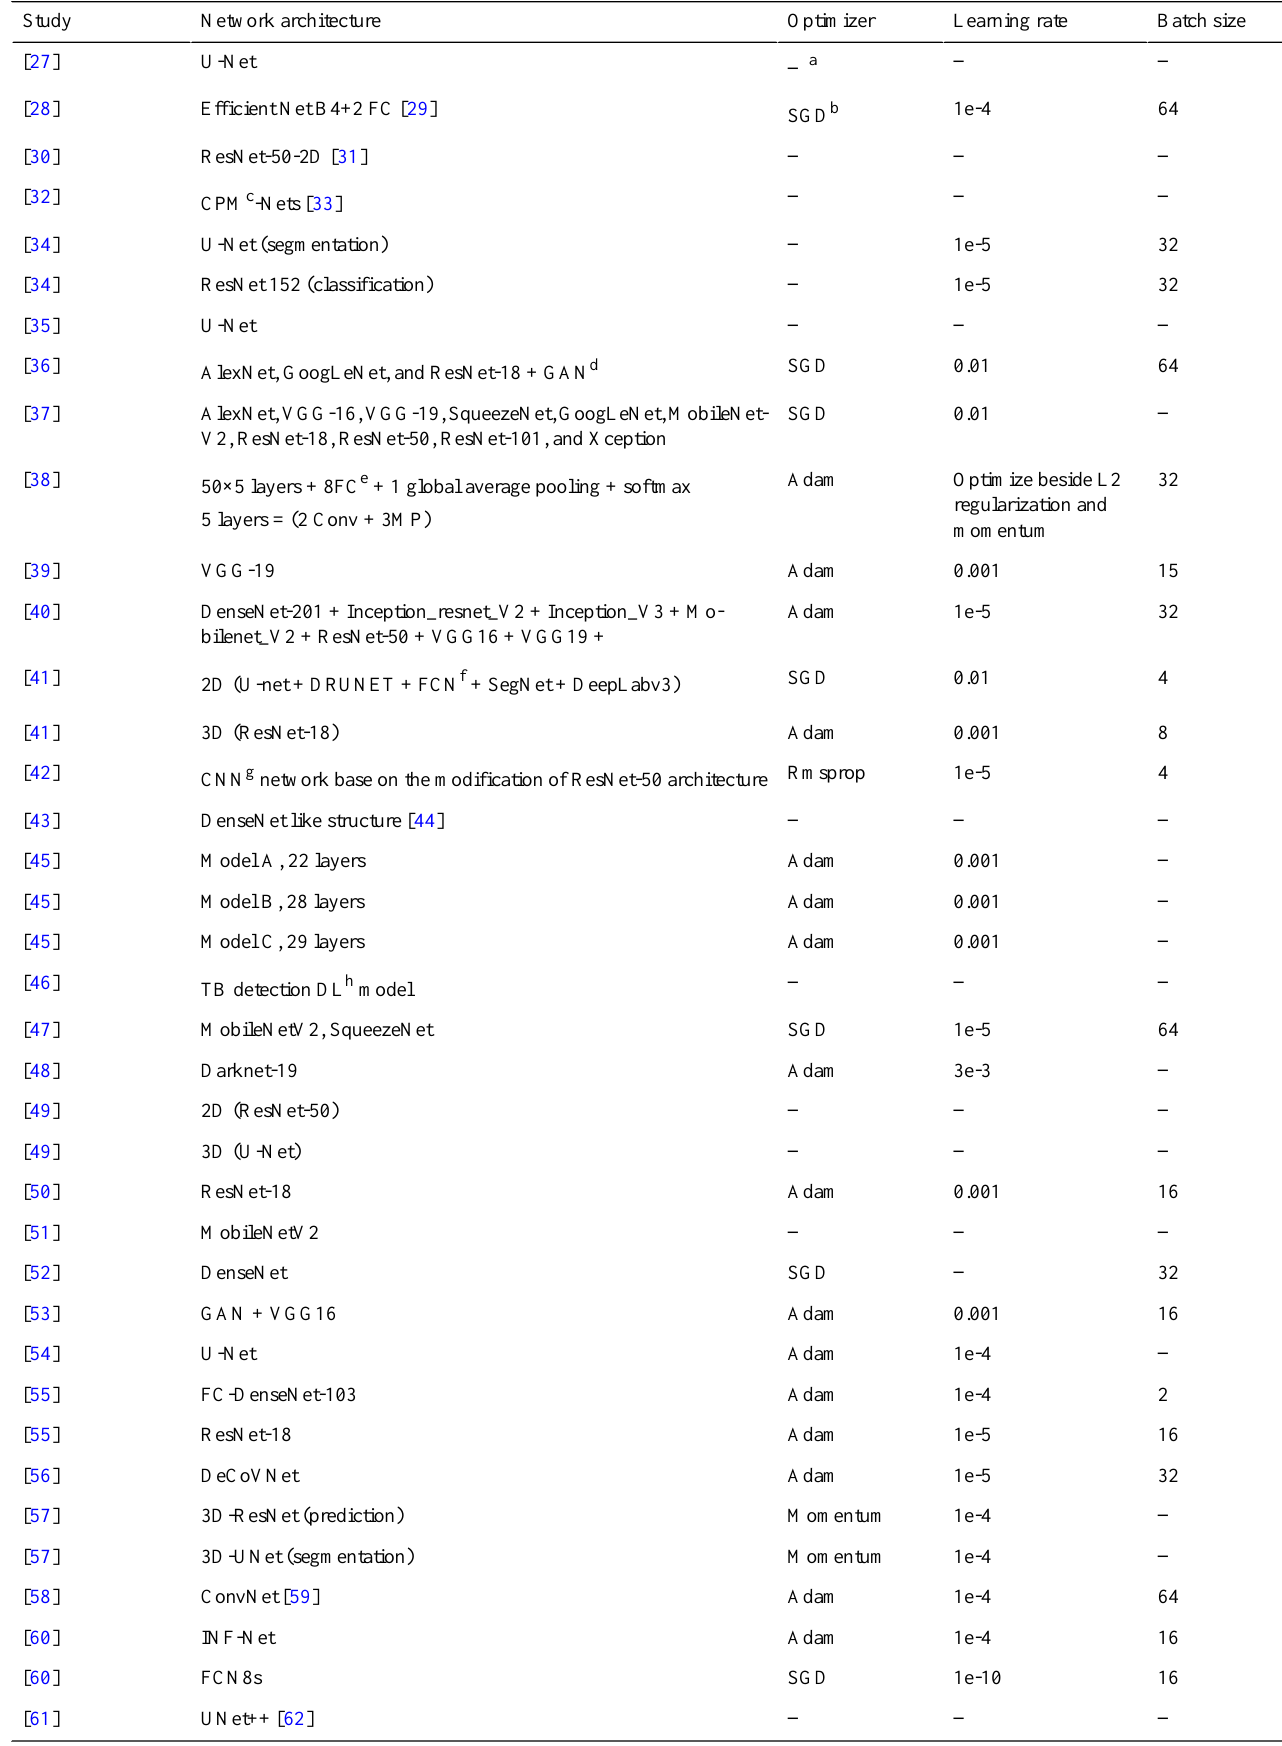
Table 1. Deep learning architecture and